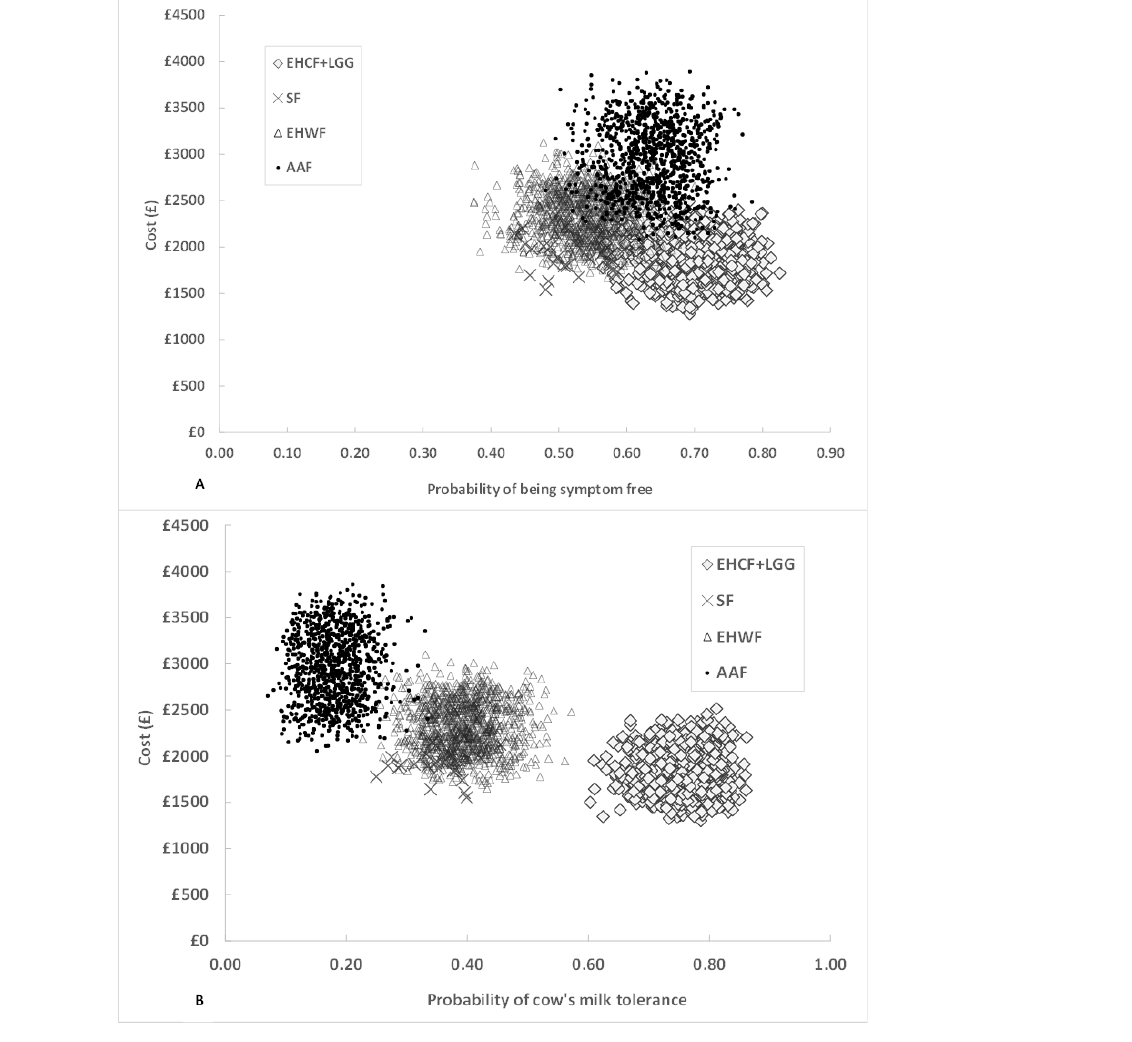
Figure 4. Cost-effectiveness Planes for Base Case Probabilistic